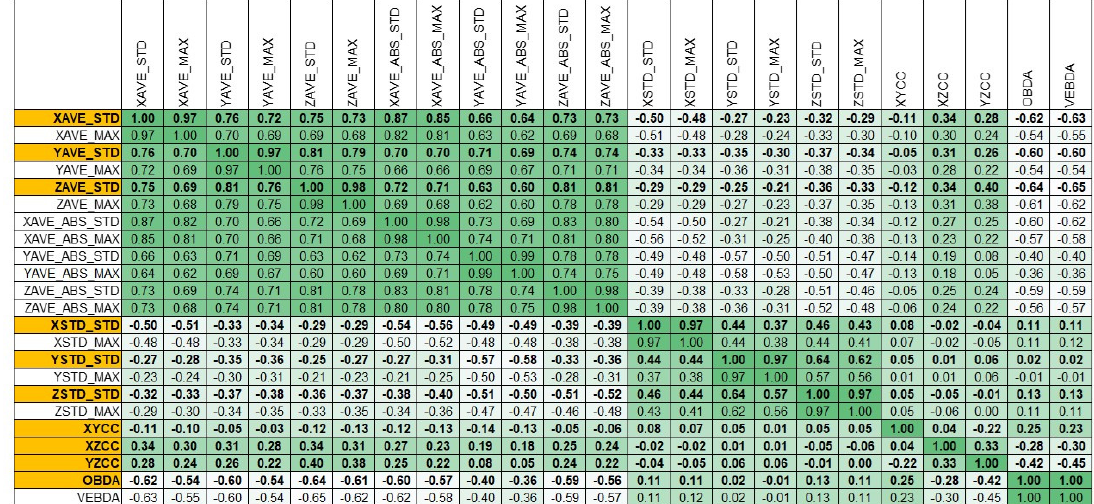
Figure 9. Features cross-correlation matrix.